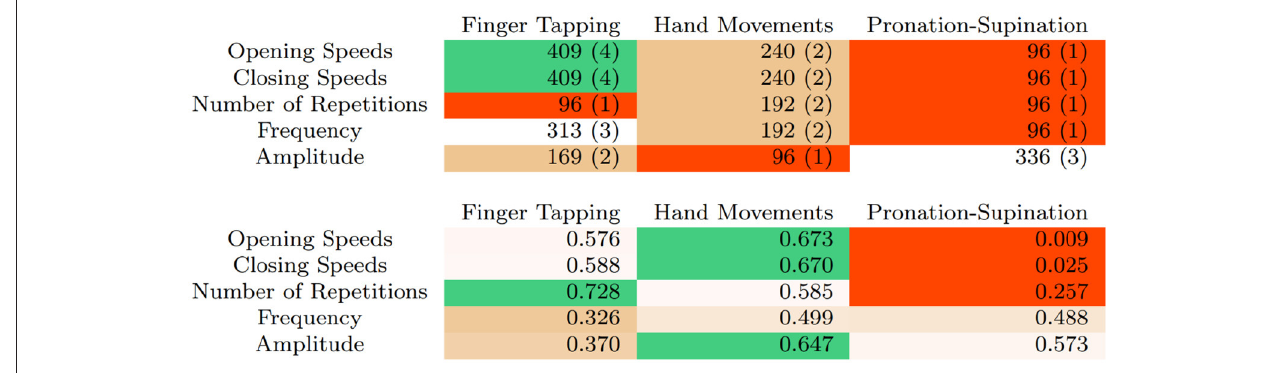
FIGURE 3 | Number of samples and (number of articles) using different variables and UPDRS bradykinesia tasks (top) and sample-weighted correlations (bottom)